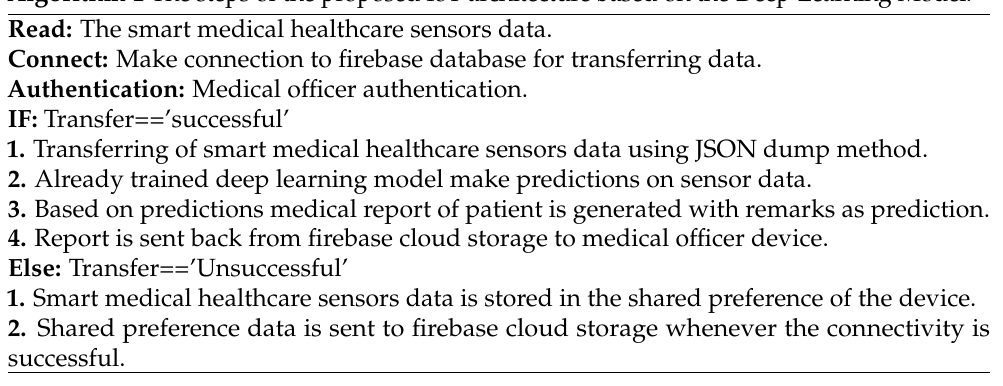
Algorithm 1 The steps of the proposed IoT architecture based on the Deep Learning